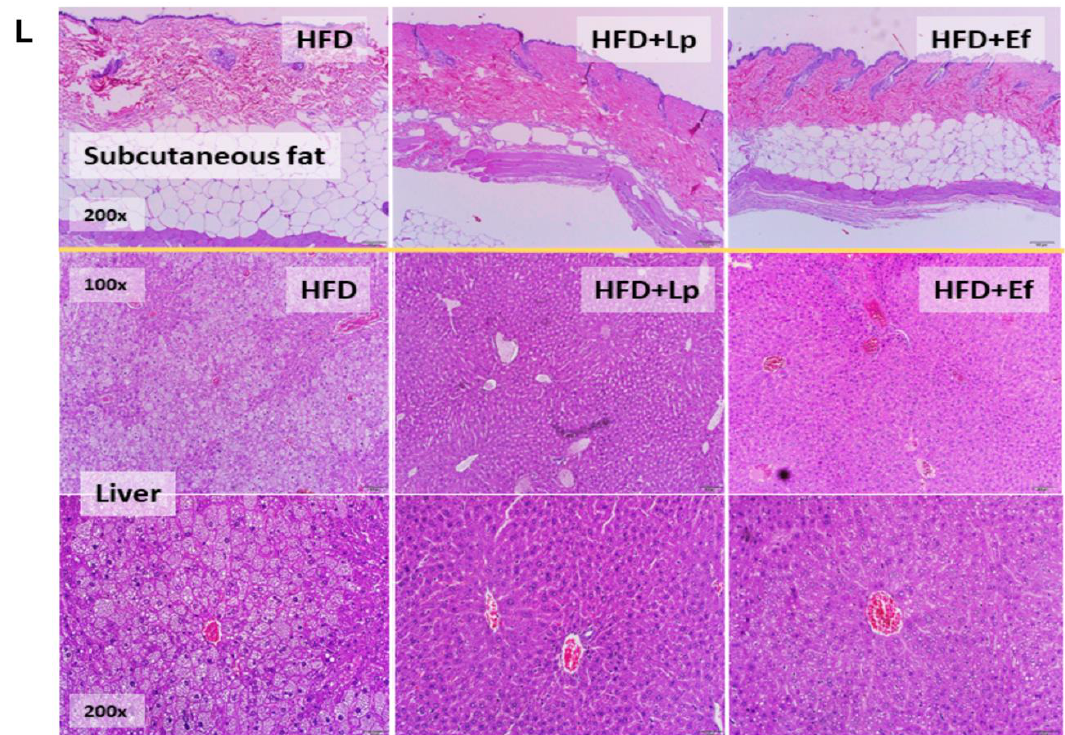
Figure 1. Characteristics of mice with regular diet (RD) or high fat diet (HFD) with or without Lactiplantibacillus plantarum (Lp) or Enterococcus faecium (Ef) as determined by body weight ( A ), fasting blood lipid profile (total cholesterol and triglyceride) ( B , C ), adipose tissue depots in several sites ( D – I ), subcutaneous fat thickness ( H ), liver injury (weight, histological score and cholesterol in liver) ( I – K ) and the representative figures of subcutaneous fat thickness and liver (original magnification 200 × ) ( L ) were demonstrated ( n = 6–8/time-point or